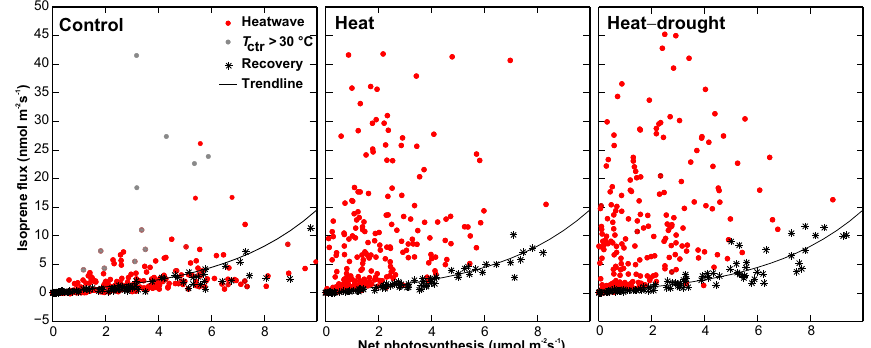
Figure 4. Relationship of isoprene emission with photosynthesis (>0µmolm − 2 s − 1 ) in black locust trees during the two heatwaves (red and grey circles; grey circles distinguish points at which the temperature in the control chambers exceeded 30 ◦ C) and recovery periods (black asterisks) shown in separate panels for the control, heat and heat–drought treatment. Solid lines represent an exponential curve of the form y = exp (αx) − β which was derived from a nonlinear fit to the measurements of heat–drought-stressed trees during recovery to describe the dependency between photosynthesis and isoprene emission